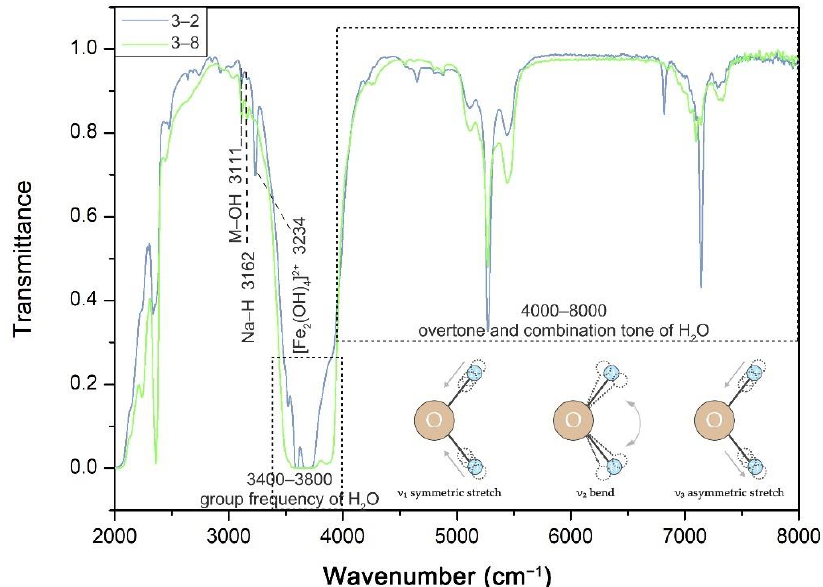
Figure 4. IR spectrum of 2000–8000 cm − 1 and characteristic peaks. Schematic diagram of the vibration model of the H 2 O molecule is in the lower right.